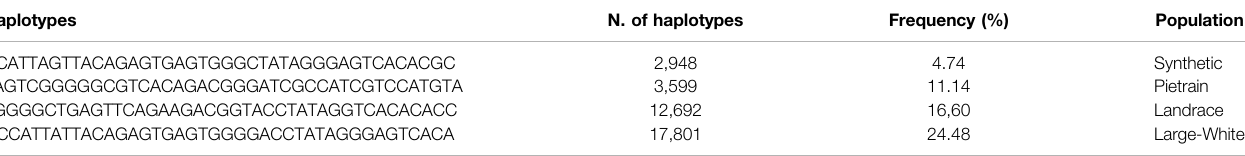
In red, lead SNP [reference allele (G)]. In green, the same region covering the core haplotype as in Table 5 .